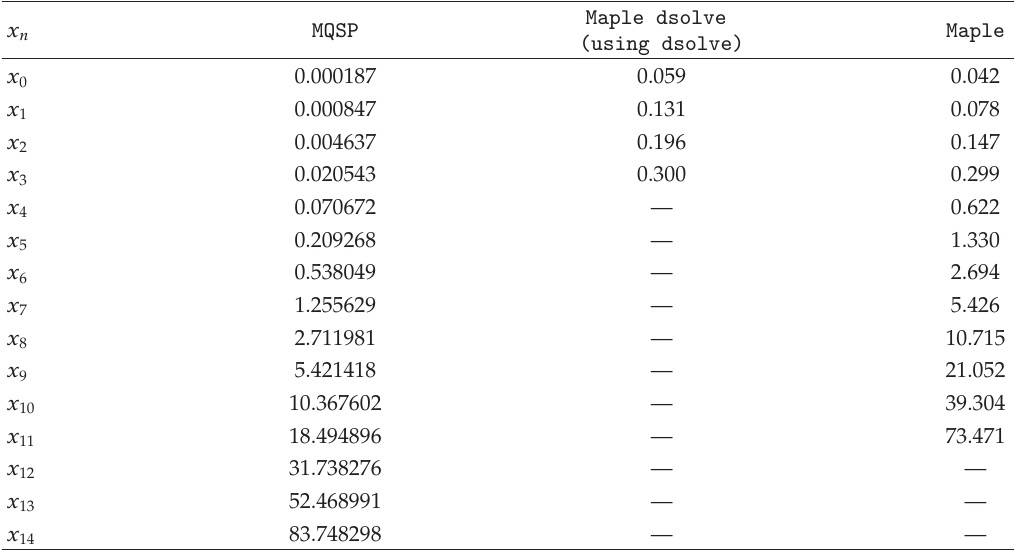
Table 3: CPU time (cid:3) in seconds (cid:4) for the implementation with the MQSP , dsolve , and Maple . x n MQSP Maple